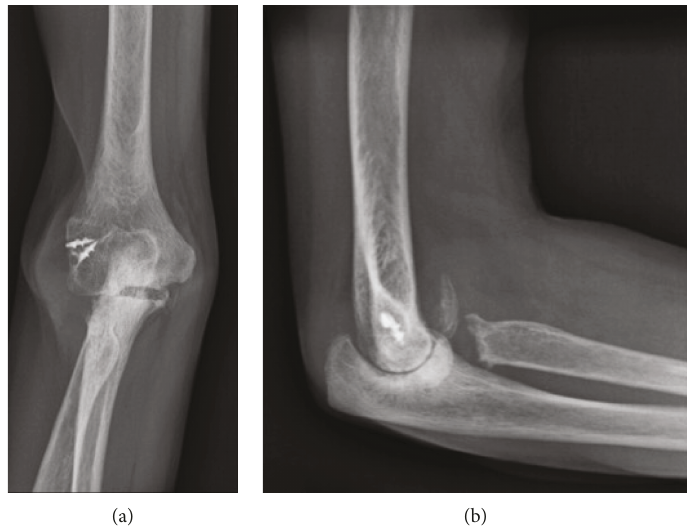
Figure 1: (a) AP and (b) lateral radiographs of the right elbow obtained upon the initial presentation to our